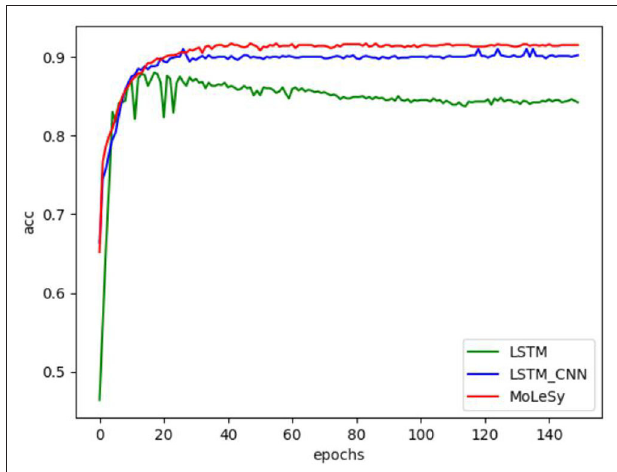
FIGURE 6 | The accuracy at different epochs on the Hotel data set.